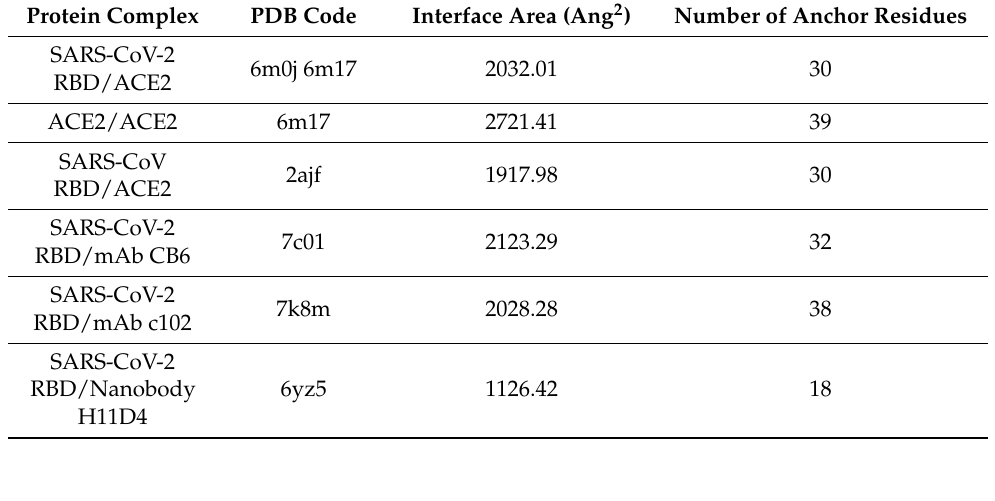
Table 1. List of protein complexes considered and interface features.